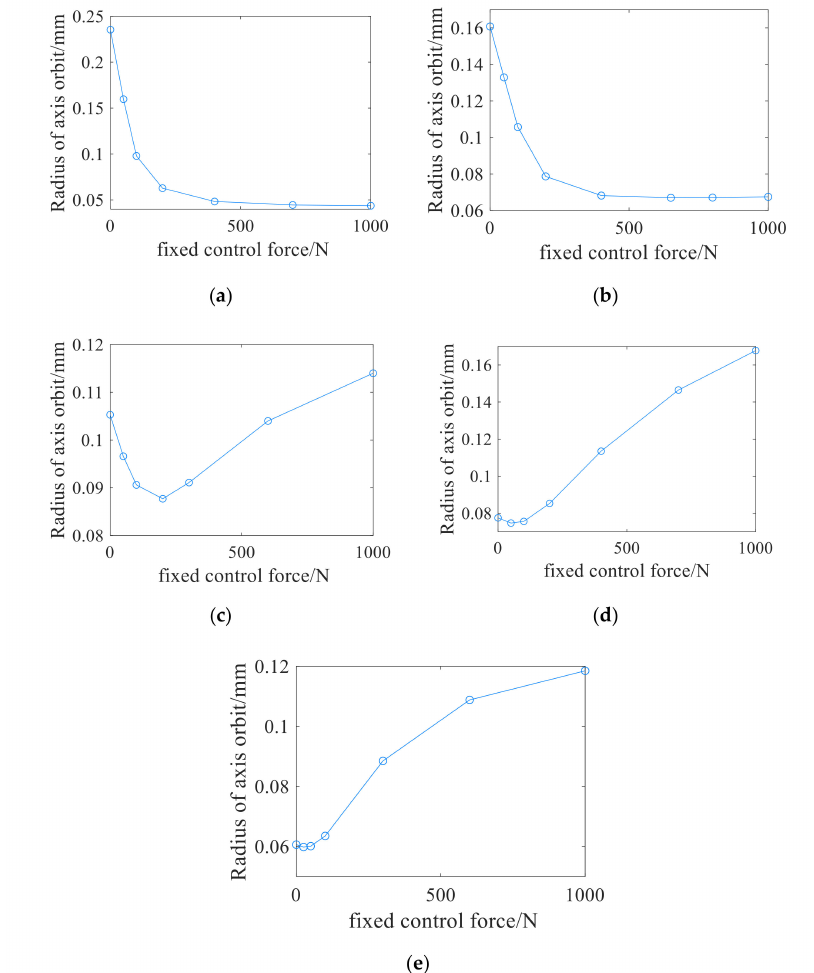
Figure19. Relationshipbetweentheradiusoftheaxisorbitandthefixedcontrolforceunder( a – e )speeds, respectively 6000 r / min, 6000 r / min, 6600 r / min, 7200 r / min, 7800 r / min and 8400 r /